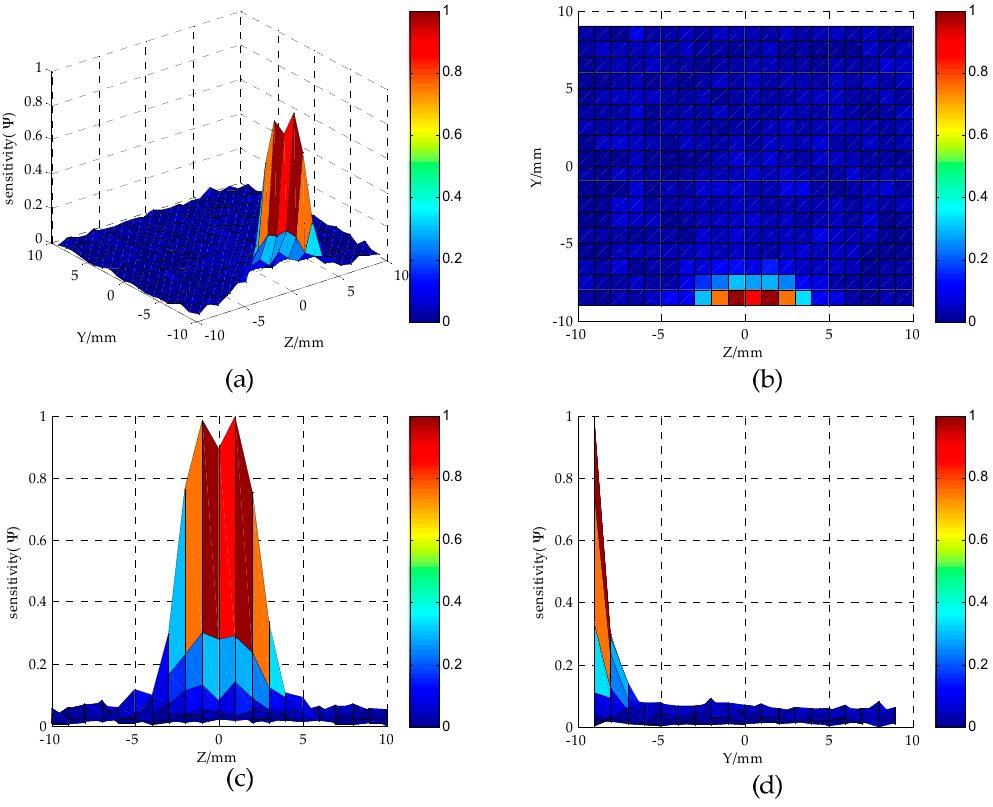
Figure 10. Sensor sensitivity distribution in YoZ plane sensitivity field ( D = 20 mm, h = 1 mm, d = 1.5 mm, S = 3 mm): ( a , b ) YoZ plane regions; ( c ) Z -axis direction; ( d ) Y -axis direction.